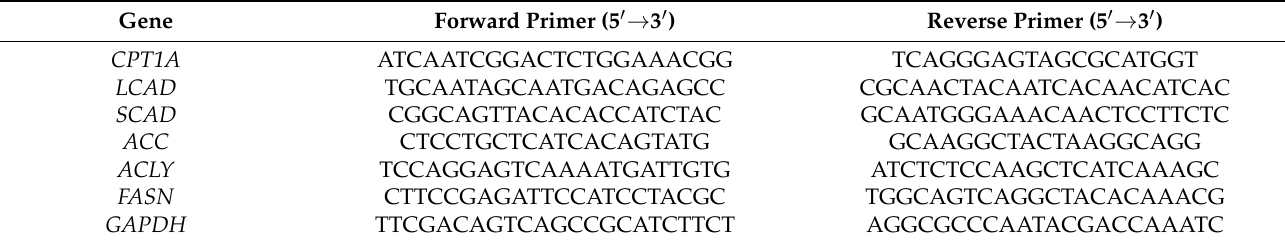
Table 1. Forward and reverse primer sequences of CPT1A , LCAD , SCAD , ACC , ACLY , and FASN for quantitative real-time. reverse transcription